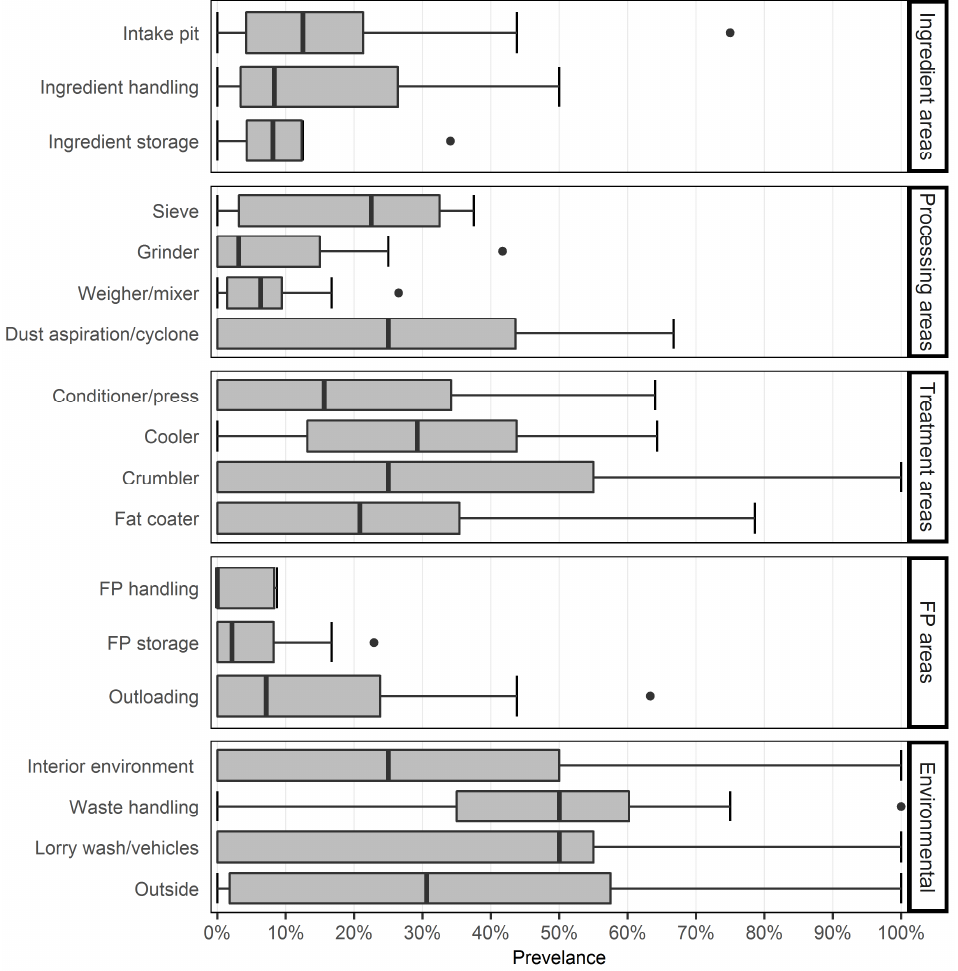
Figure 1. Boxplot of prevalence values of Salmonella -positive samples from feed mills, grouped by sampling location. Each box shows the median and interquartile range (IQR), and whiskers extend to the show the 2.5th percentile and the 97.5th percentile of the data. Outliers, data beyond the end of the whiskers, are plotted individually. Data are shown for feed mill visits where Salmonella was isolated from five percent or more of samples.